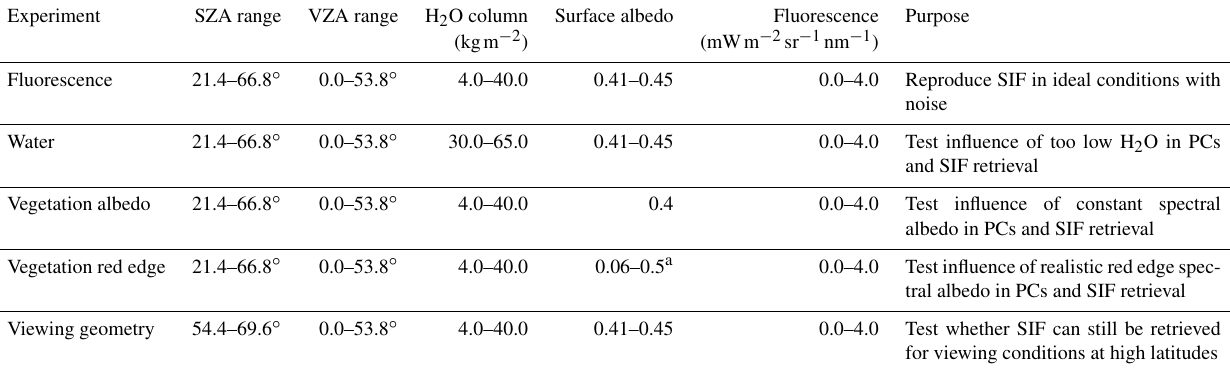
Table 1. Settings for the five experiments with DISAMAR. All experiments were done without clouds, and signal-to-noise ratio of the simulated reflectance spectra was 1000. SZA stands for solar zenith angle, and VZA stands for viewing zenith angle.